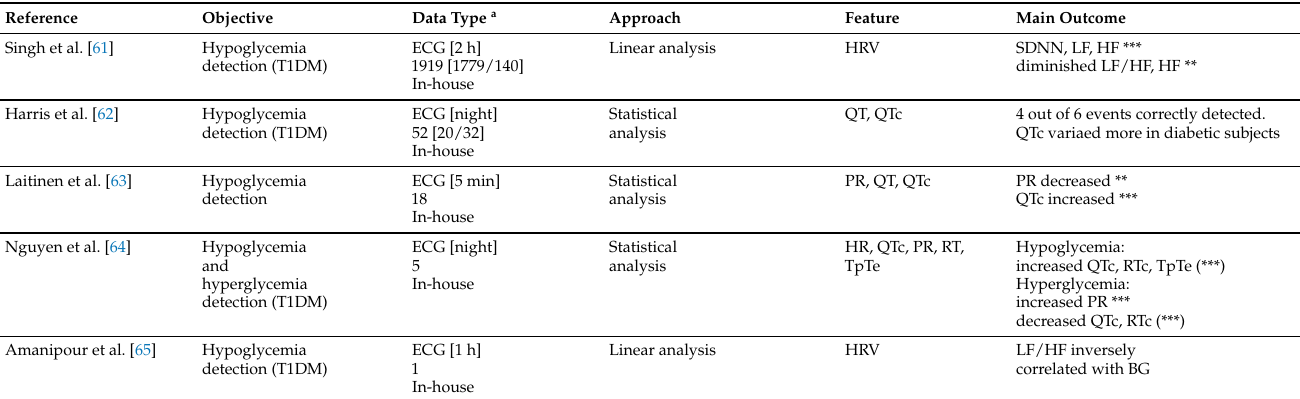
Table 3. Traditional methods for blood glucose